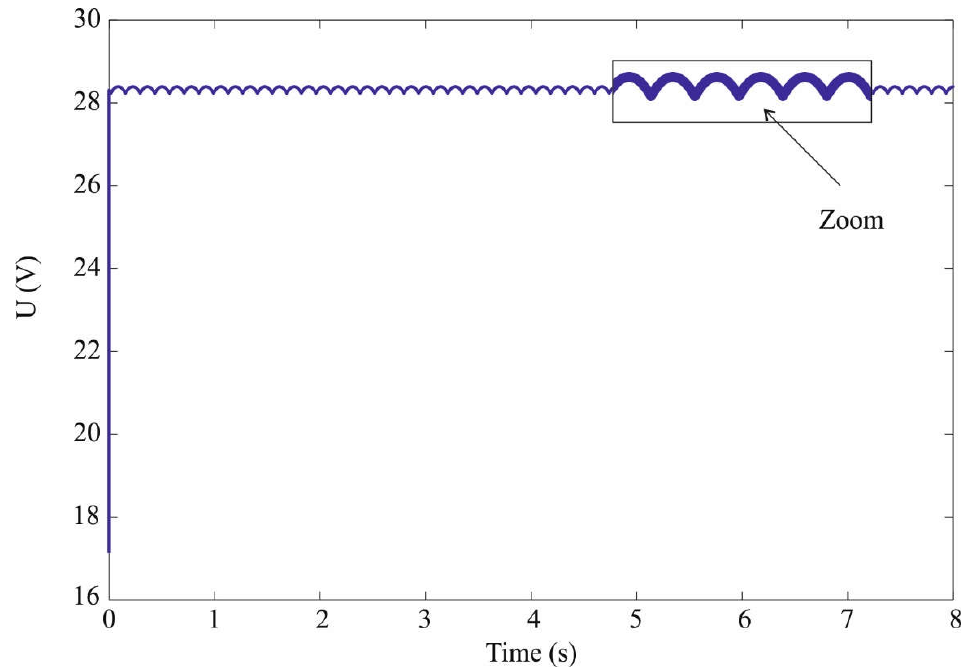
Figure 6. Voltage waveforms in the ATRU unit, based on the structure of a 12-pulse rectifier for output voltage 28 V.